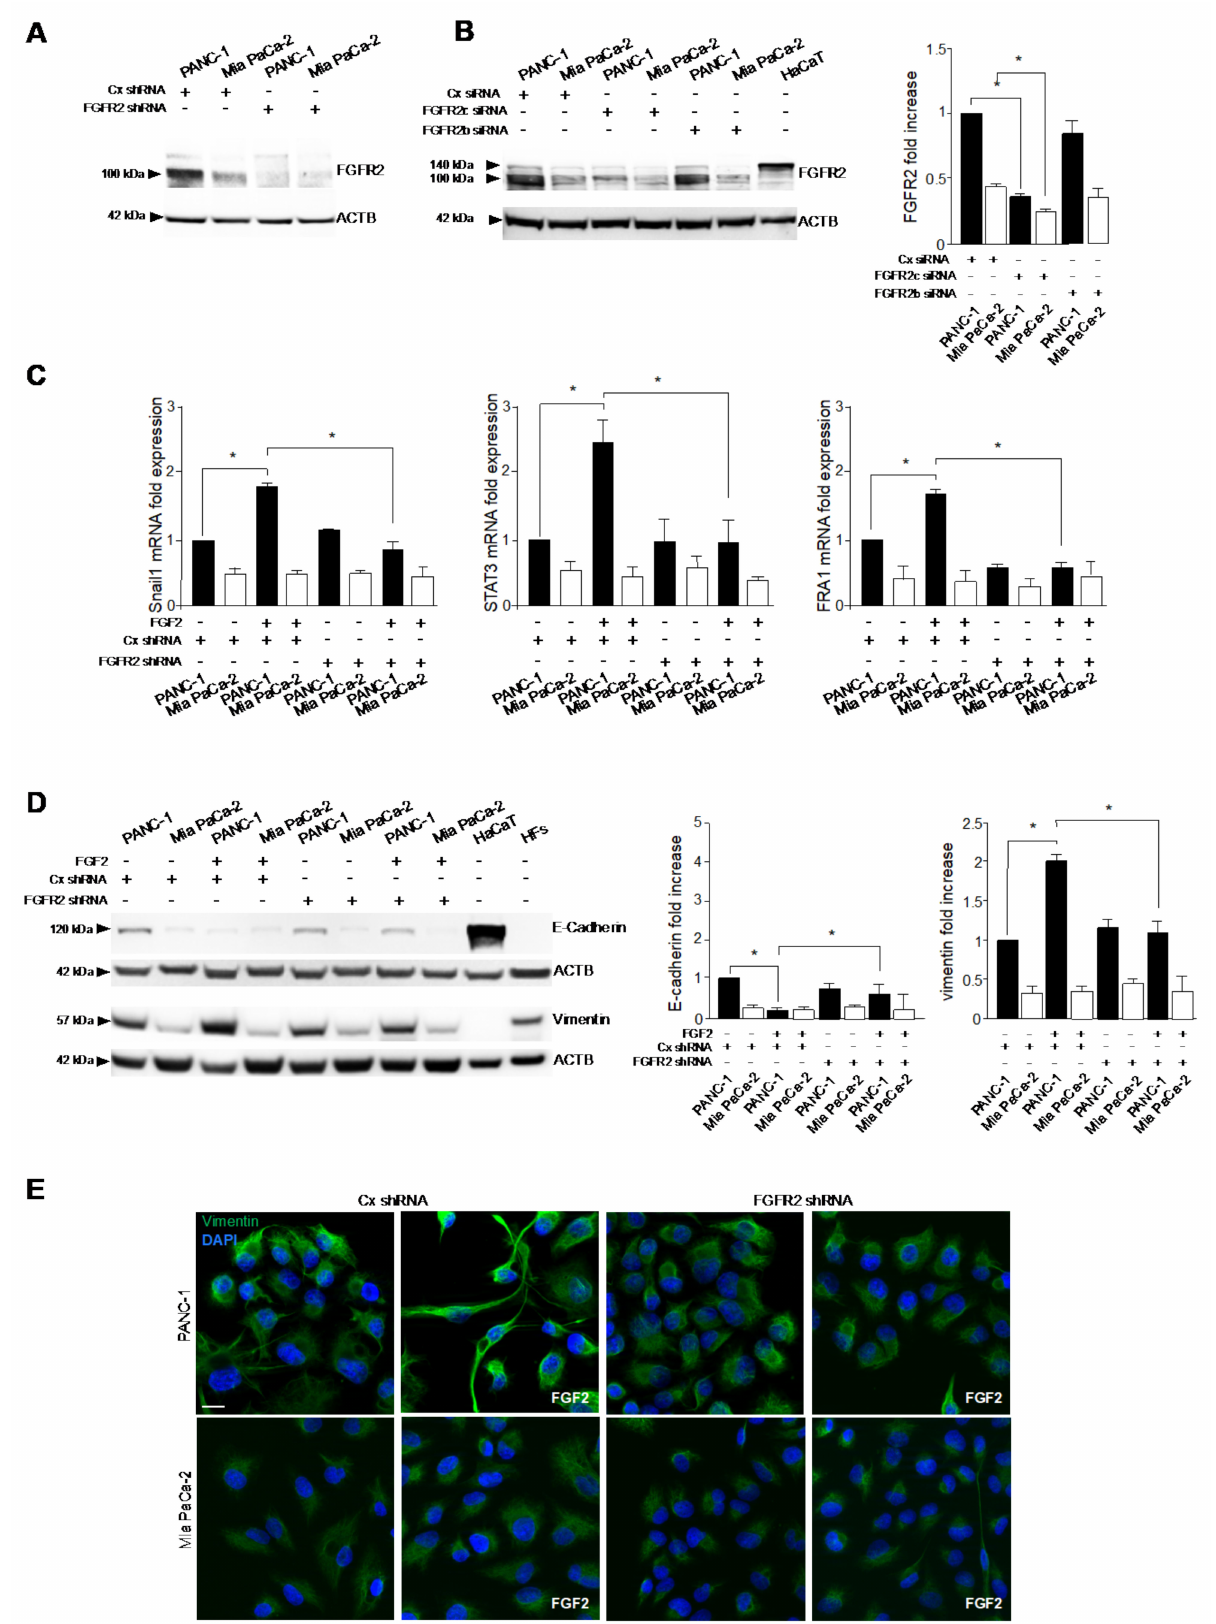
Figure 3. FGFR2c depletion affects the responsiveness of PANC − 1 cells to FGF2 in terms of enhancement of the mesenchymal expression profile. PANC − 1 and Mia PaCa − 2 cells were stably transduced with FGFR2 shRNA or alternatively